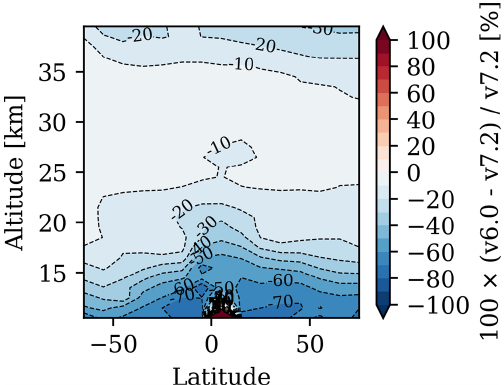
Figure 2. Mean percent difference between v6.0 and v7.2 OSIRIS NO 2 for all observations from November 2001 to May 2020. Bin spacing is 1km and 10 degrees of